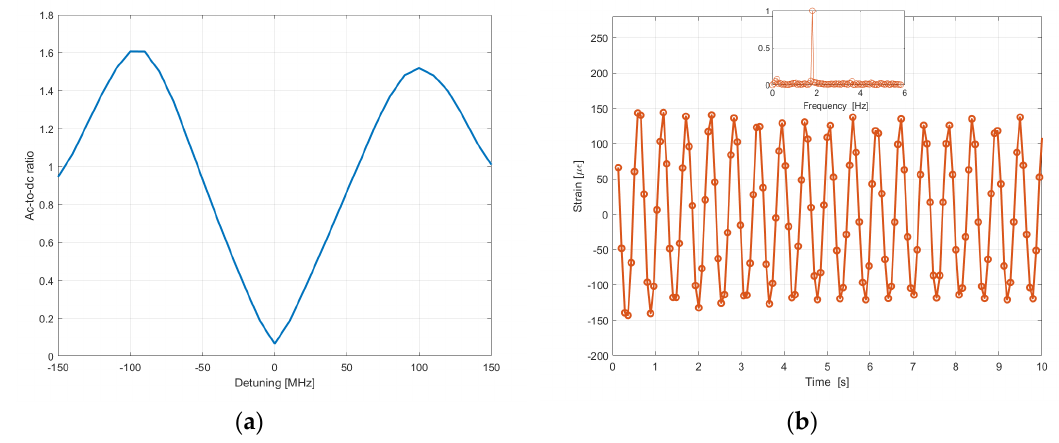
Figure 13. ( a ) Amplitude of the heterodyne signal normalized to its dc value, computed for a pulse duration of 10 ns, as a function of detuning from resonance ( b ) Dynamic strain measured on a 1-m long cantilever beam subjected to vibration. (The inset shows the FFT of the acquired waveform [60]).